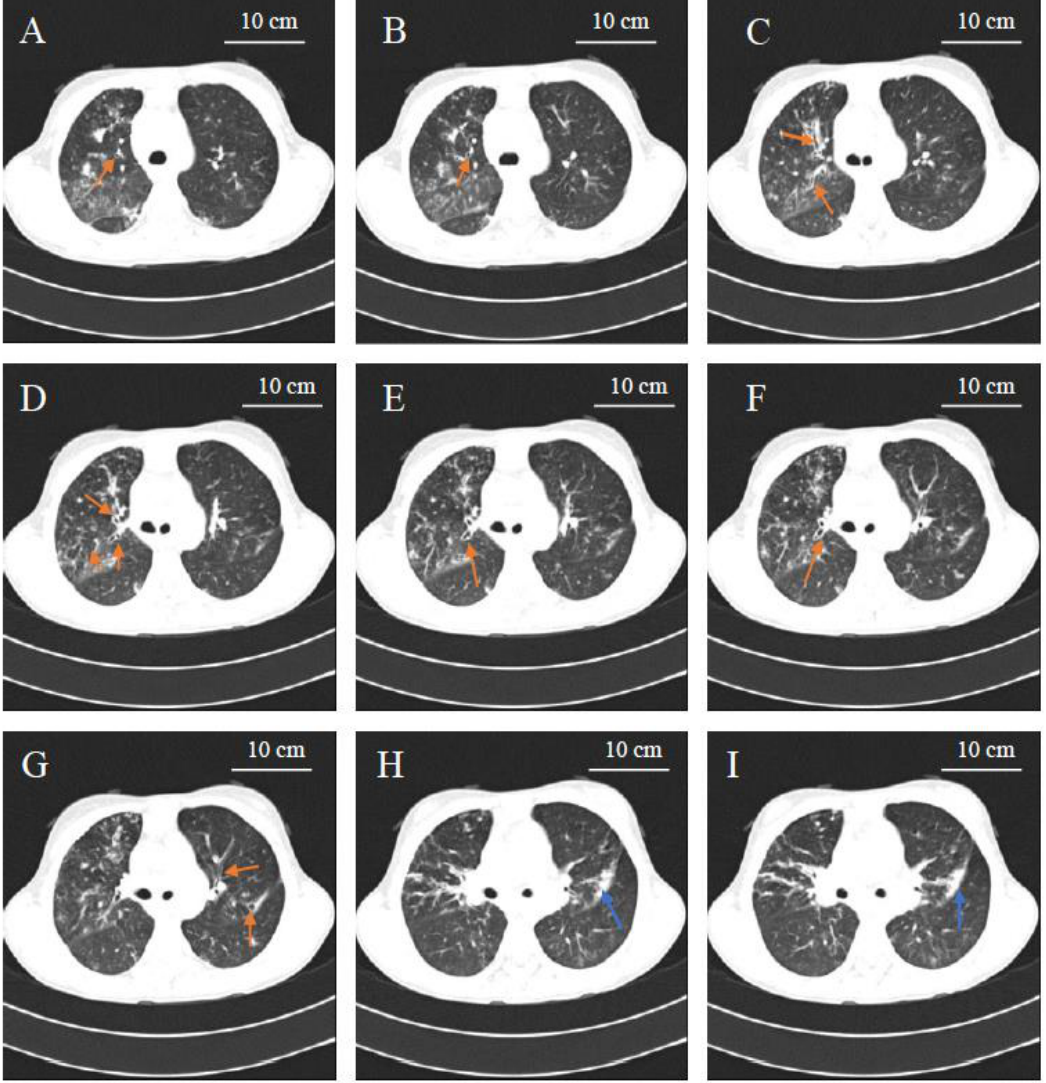
Figure 1. Axial computed tomography (CT) image demonstrating multiple bronchiectasis in the middle lobe of the right lung field (indicated in the A – F panels with orange arrows), left lower lobe bronchiectasis (highlighted in panel G with orange arrows), pulmonary sclerosis in the lower lobe of left lung field (indicated in panels H and I with blue arrow). CT instrument: Siemens Somatom Sensation 16 EDE 5,6